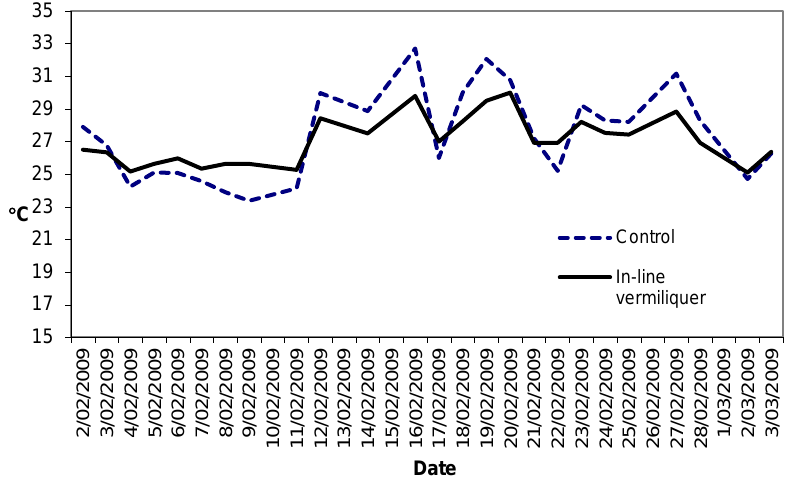
Figure 3. Temperature (°C) in the control and in-line vermiliquer nutrient solutions in Study IV, measured in the early morning.